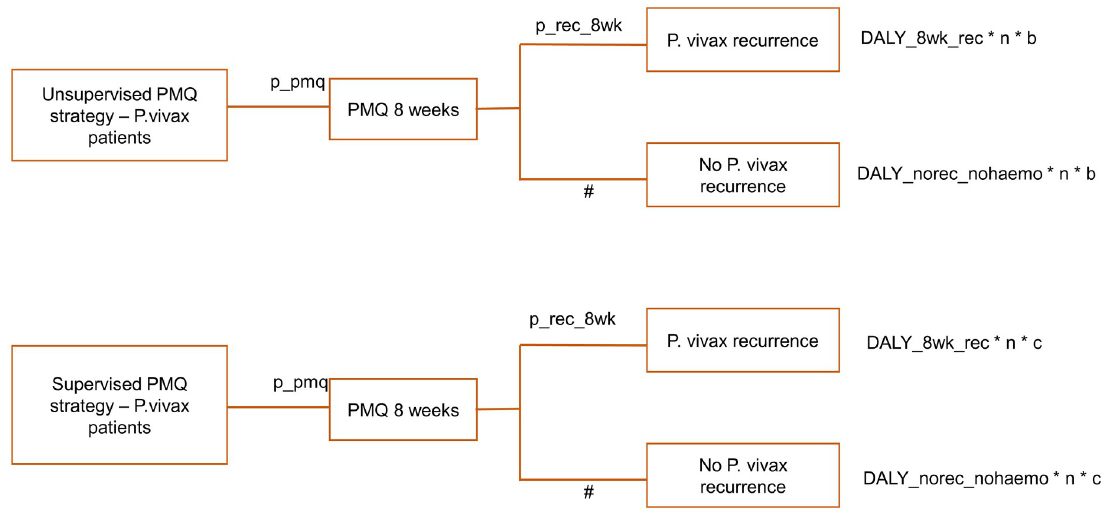
Fig 2. Decision tree model for unsupervised PMQ strategy and supervised PMQ strategy.